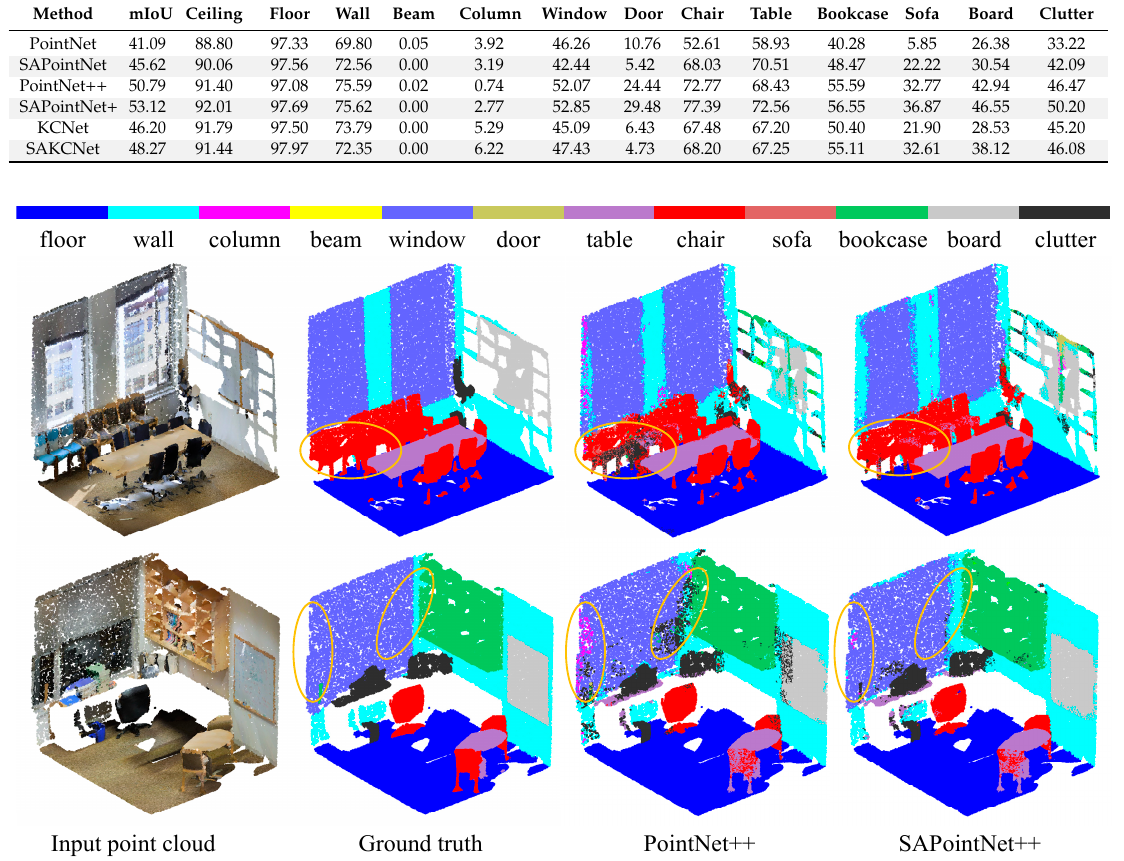
Figure 6. Semantic segmentation results on the S3DIS dataset. Two conference rooms and their segmentation results with PointNet ++ [19] and our SAPointNet ++ are provided since their multi-scale feature learning mechanism is more suitable for the semantic segmentation task. For visual convenience, the ceiling of each room and parts of wall are not shown.